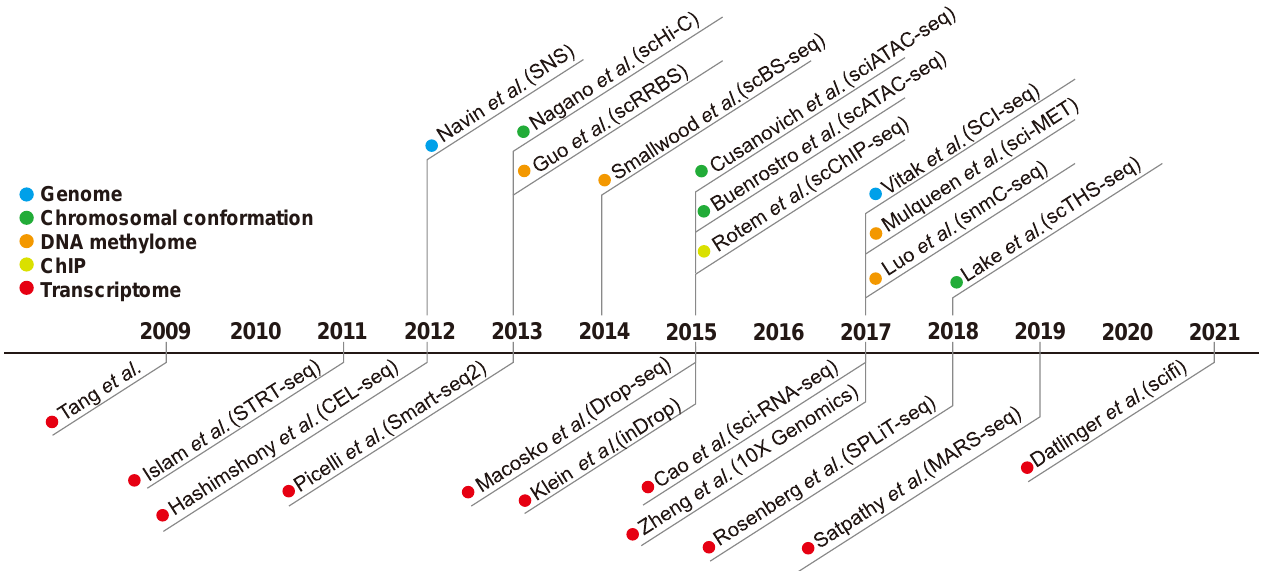
Figure 1. Timeline of technical progress of single-cell analysis. Each method was divided into five categories (genome, chromosomal conformation, DNA methylome, ChIP, and transcriptome) and identified by different colors.